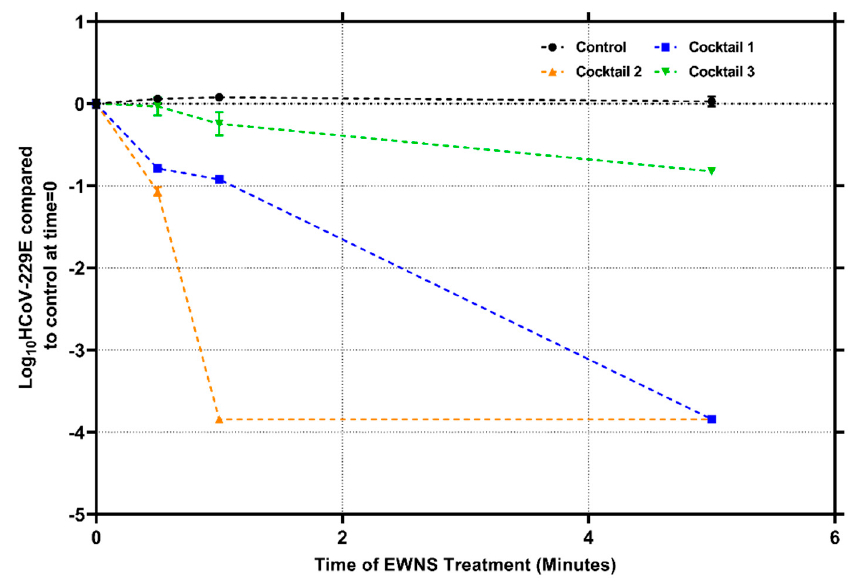
Figure 3. Inactivation of HCoV-229E on surface, after treatment with EWNS. The active ingredient cocktail utilized for producing each EWNS for treatment is indicated. Error bars represent standard deviation.